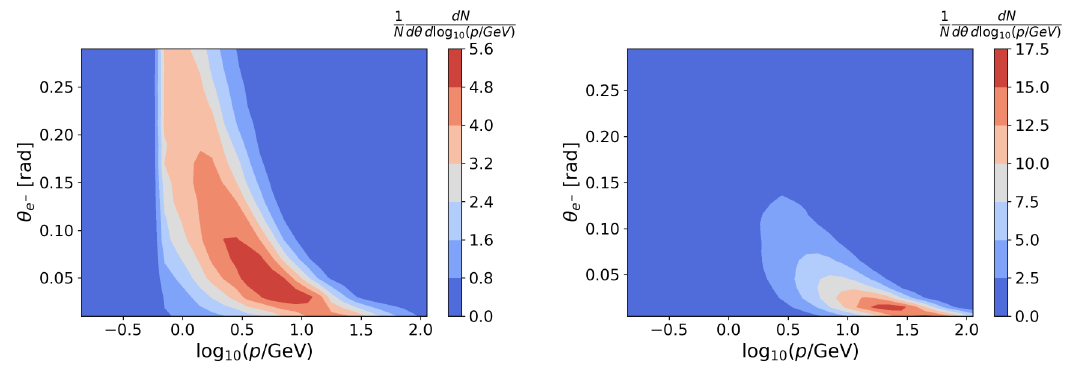
Figure 6. 2D contour plot of the momentum ( p ) and the production angle ( θ ) correlation for π 0 s produced in the collisions of 400 GeV protons hitting the SHiP beam-dump target. Left: simulation with FairShip including π 0 production in the interactions of secondary hadrons with the target nuclei. Right: simulation of the prompt proton-nucleon π 0 production with Pythia